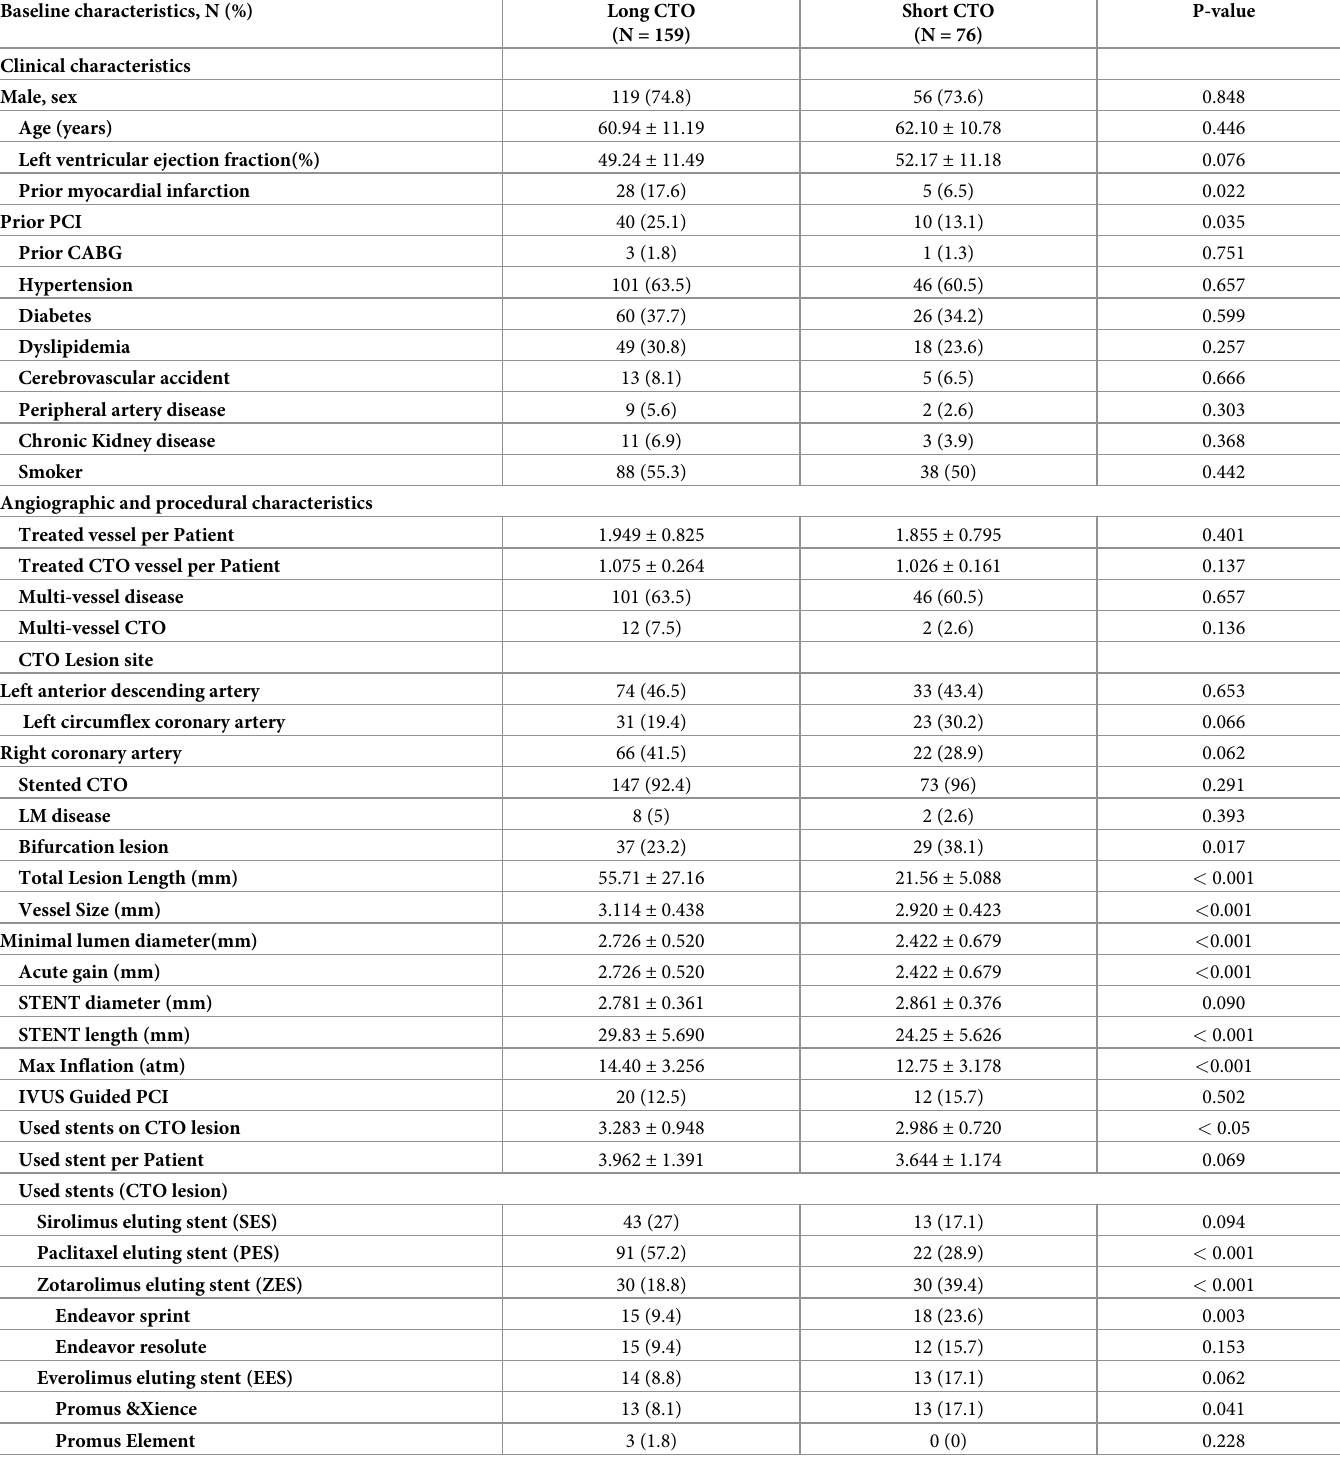
Table 1. Baseline clinical, angiographic and procedural